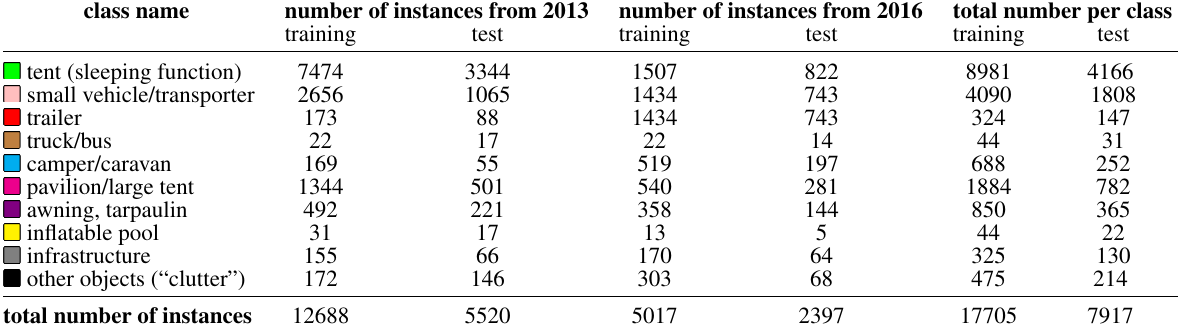
Table 1. Overview of the ten classes contained in the dataset and their instance numbers. formance in different scales at a marginal extra cost.